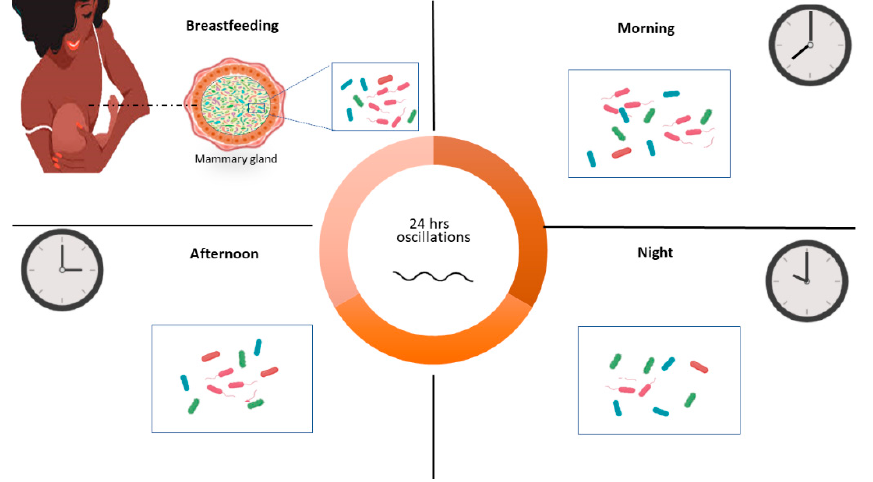
Figure 3. Model for the bacterial diversity change during the day. Bacterial microbiota show variations in diversity and composition between the morning and night. This could have an impact on the infant